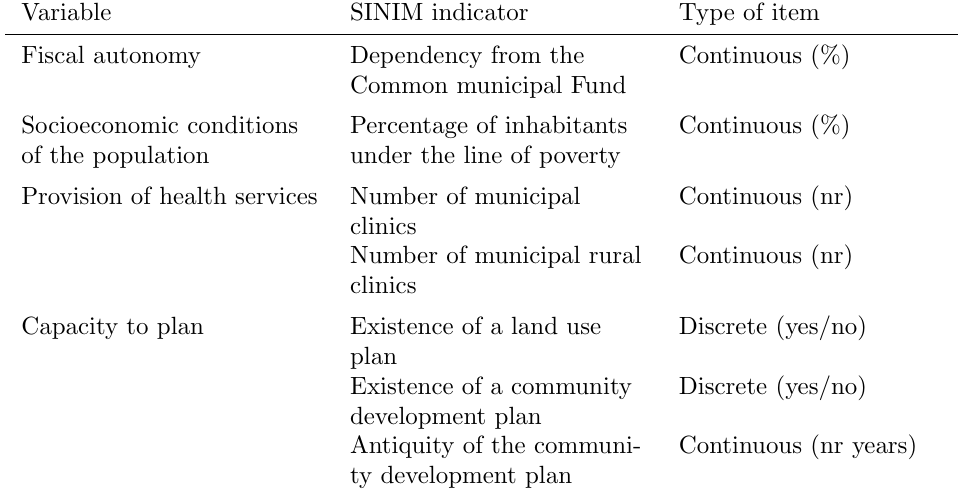
Table 1: Variables and indicators used for the synthetic index of institutional